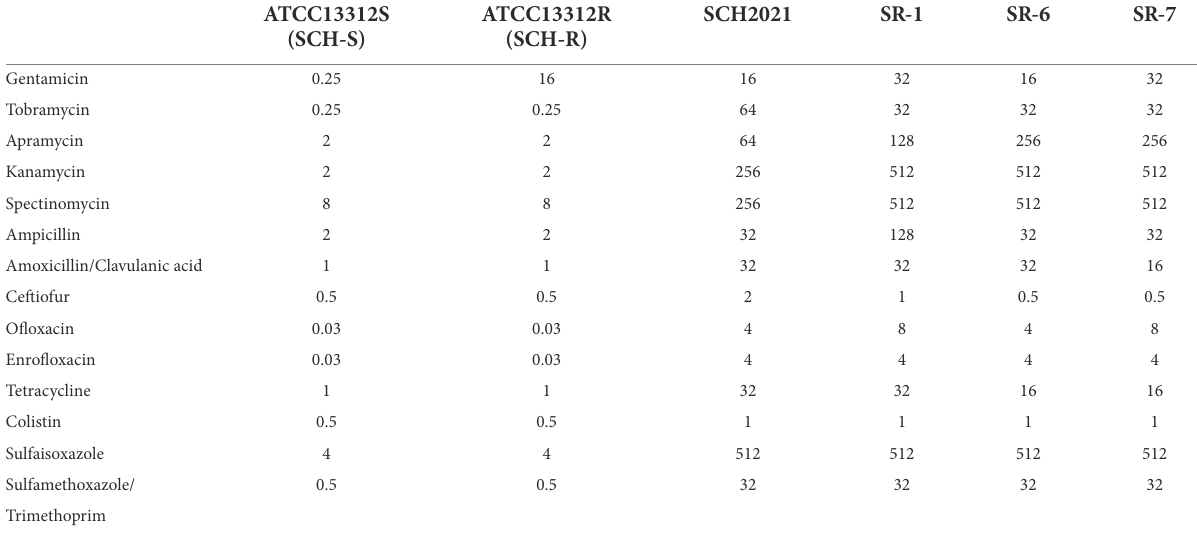
TABLE 1 MIC value of different antimicrobials against Salmonella ( μ